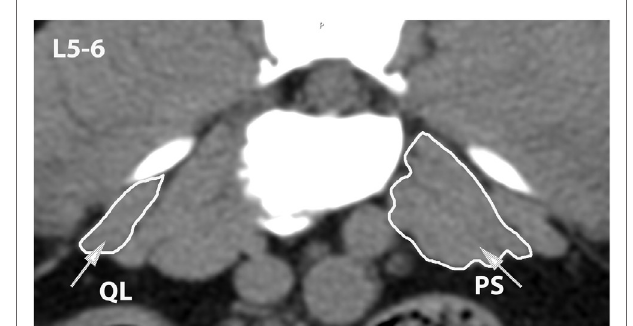
FIGURe 11 | transverse Ct image at the level of L5–6, illustrating margins of the quadratus lumborum (QL) and psoas (Ps) muscles